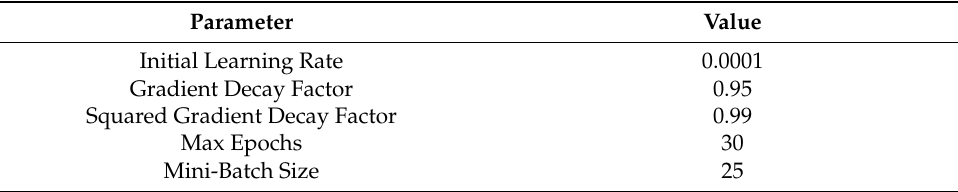
Table 3. Hyper-parameters used to train GoogLeNet.